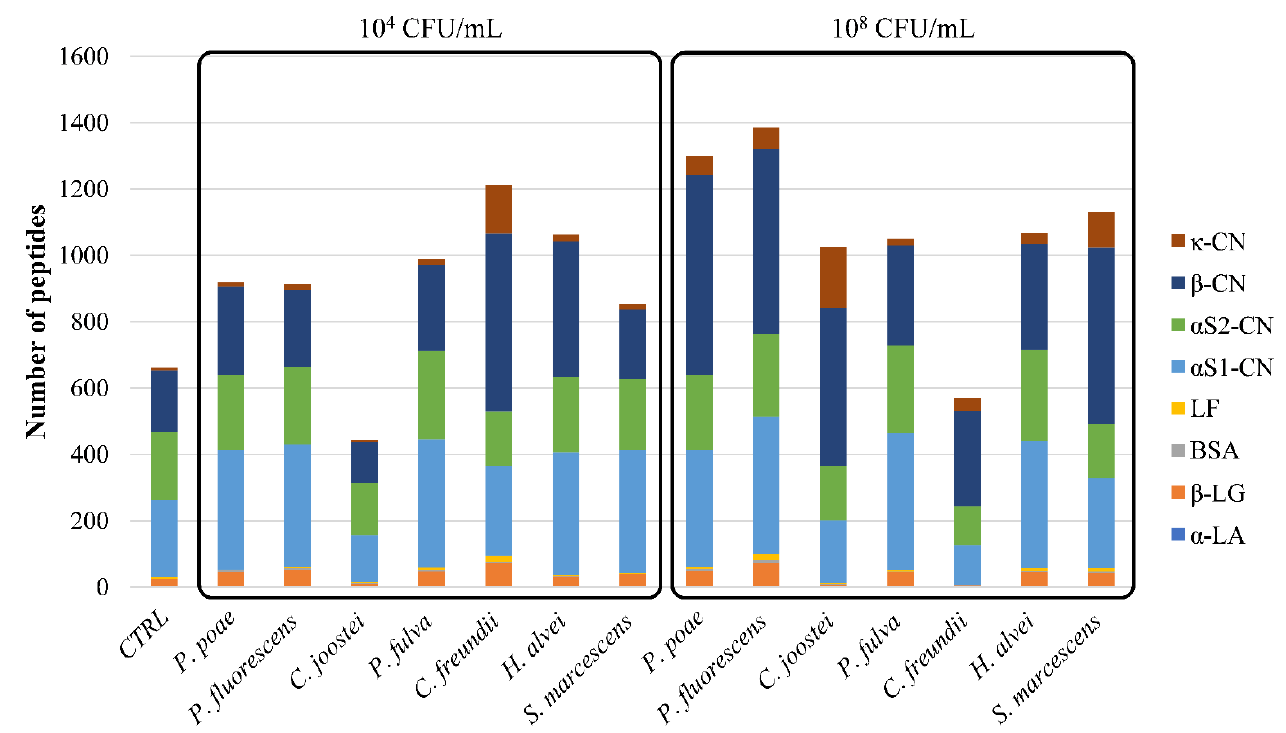
Figure 3. Number and precursor proteins of the peptides identified after incubation at 45 °C for 100 days in CTRL sterilized milk (CTRL) and in milk samples sterilized when the psychrotrophic count of pasteurized milk reached 10 4 or 10 8 CFU/mL. κ-CN, κ-casein; β-CN, β-casein; α S2 -CN, α S2 -casein; α S1 -CN, α S1 -casein; LF, lactotransferrin; BSA, bovine serum albumin; β-LG, β-lactoglobulin; α-LA, α-lactalbumin.